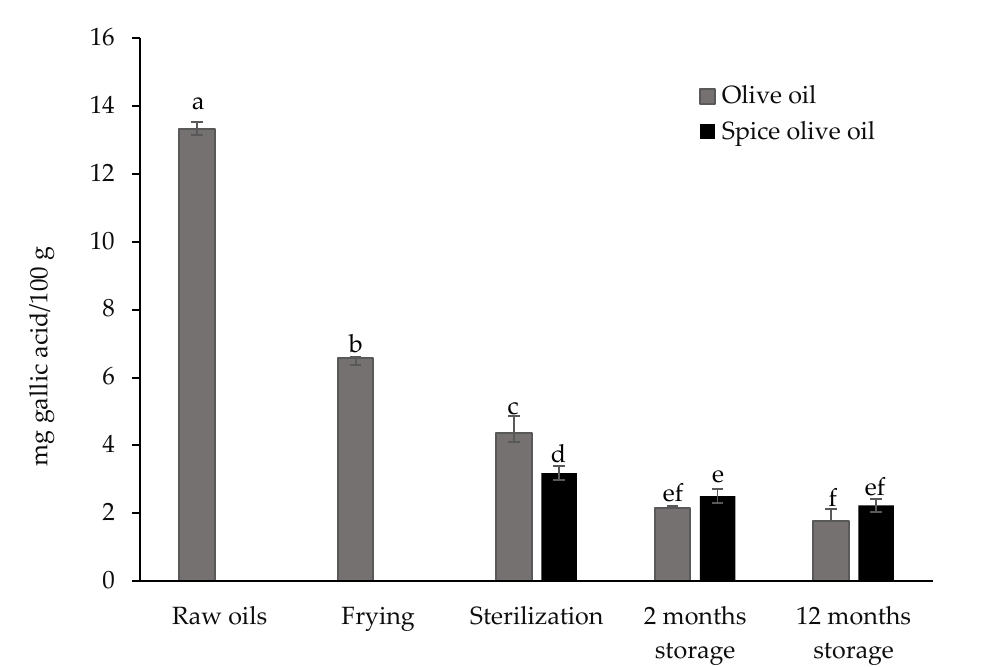
Figure 5. Total phenols (mg gallic acid/100 g) of olive oil and spiced olive oil after each step during the canning process and after 2 and 12 months of subsequent storage. a–f Mean values with different letters are significantly different ( p < 0.05).